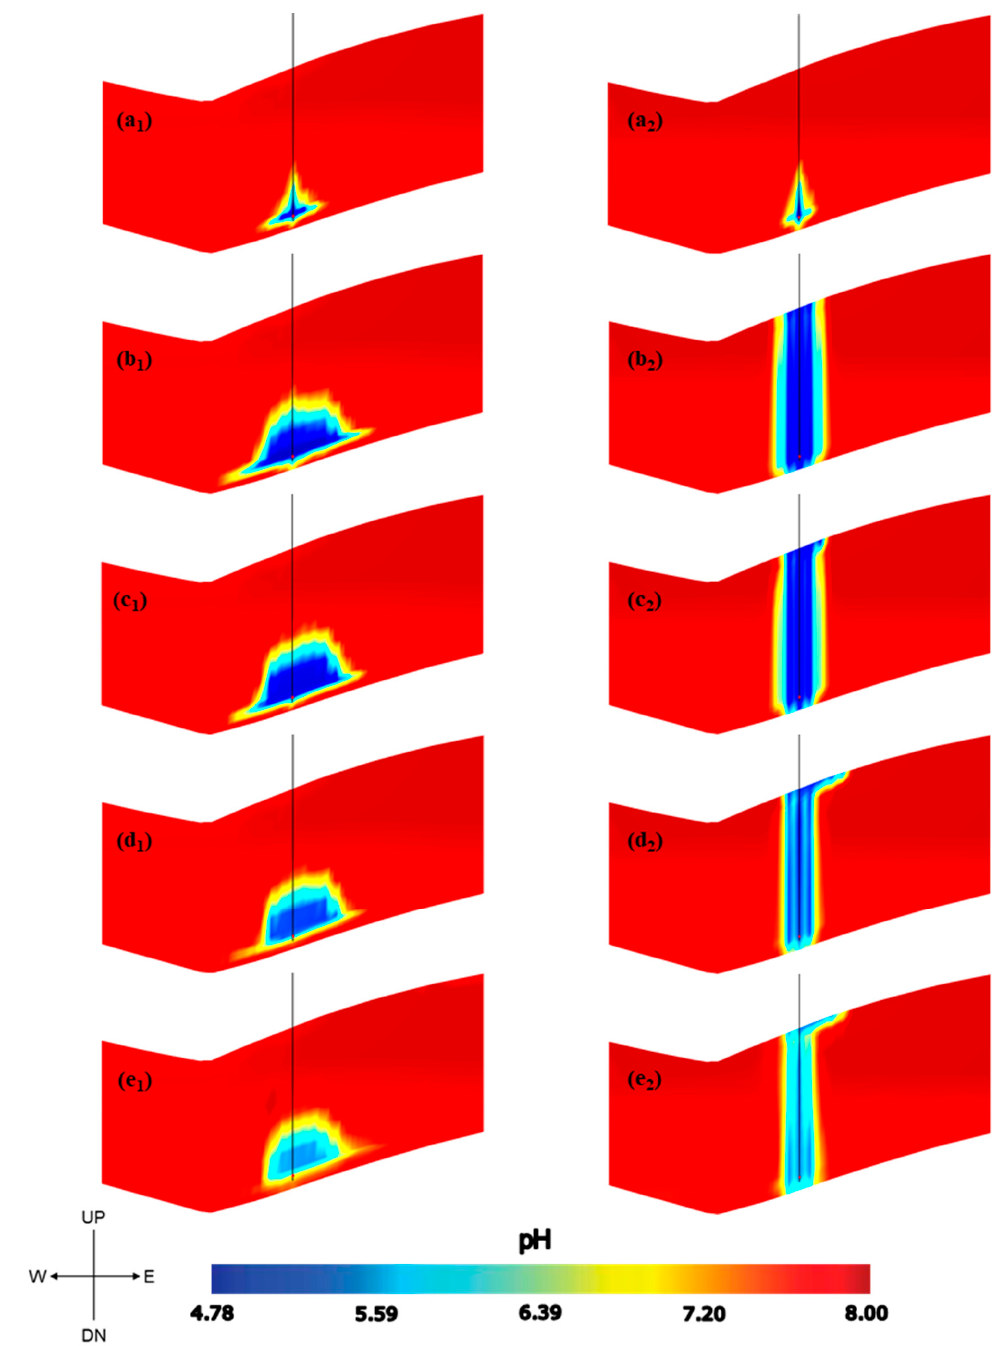
Figure A1. Fence diagrams illustrating the simulated pH evolution for the base case ( a 1 , b 1 , c 1 , d 1 , e 1 ) and homogeneous case ( a 2 , b 2 , c 2 , d 2 , e 2 ) at ( a ) 1 year, ( b ) 30 years, ( c ) 100 years, ( d ) 1000 years, and ( e ) 10,000 years. Each figure’s size is approximately 35 km × 550 m (x, z).